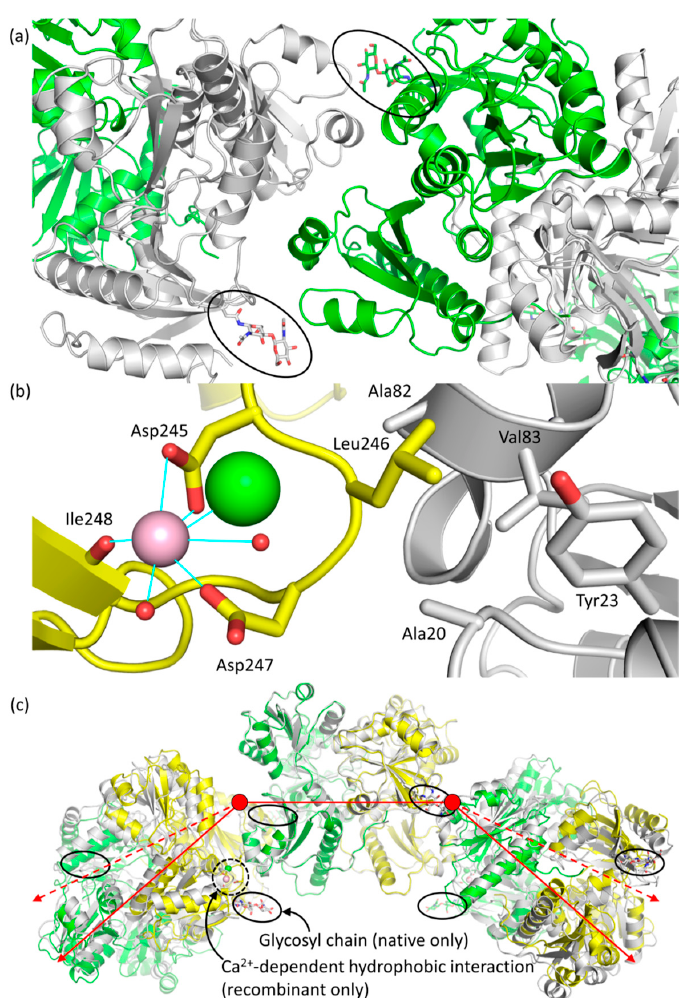
Figure 7. ( a ) An overhead view of a back-to-back interface showing the positioning of the glycosyl chains and the apparent steric constraints that they place on the polymer; ( b ) Close up of the Ca 2+ -dependent hydrophobic interaction seen in recombinant bovine Casq1. Relevant residues are labeled. The pink spheres represent Ca 2+ ions and the green sphere represents a chloride ion, and the two small red spheres represent water molecules. Solid blue lines represent coordination bonds observed in the electron density map; ( c ) Least squares superposition of C α atom in monomers A and A ′ (central dimer) between their native hexameric form (from left to right, green, gray, green, gray, green and gray) and recombinant hexameric form (from left to right, gray, yellow, gray, yellow, gray and yellow). Glycosyl chains are circled with a black line, and the Ca 2+ -dependent hydrophobic interaction, only seen in high-Ca 2+ recombinant, is circled with a black dotted line. The red lines are two-dimensional vector representations of the three dimers that compose the hexamer, with the dashed red lines indicating the deviation of recombinant Casq1 from native. In three-dimensional space and from a side-on perspective, each dimer of native Casq1 is rotated 18° with respect to the point at which two dimeric vectors meet (red circle) within their back-to-back interface, whereas recombinant Casq1 is rotated by only one.